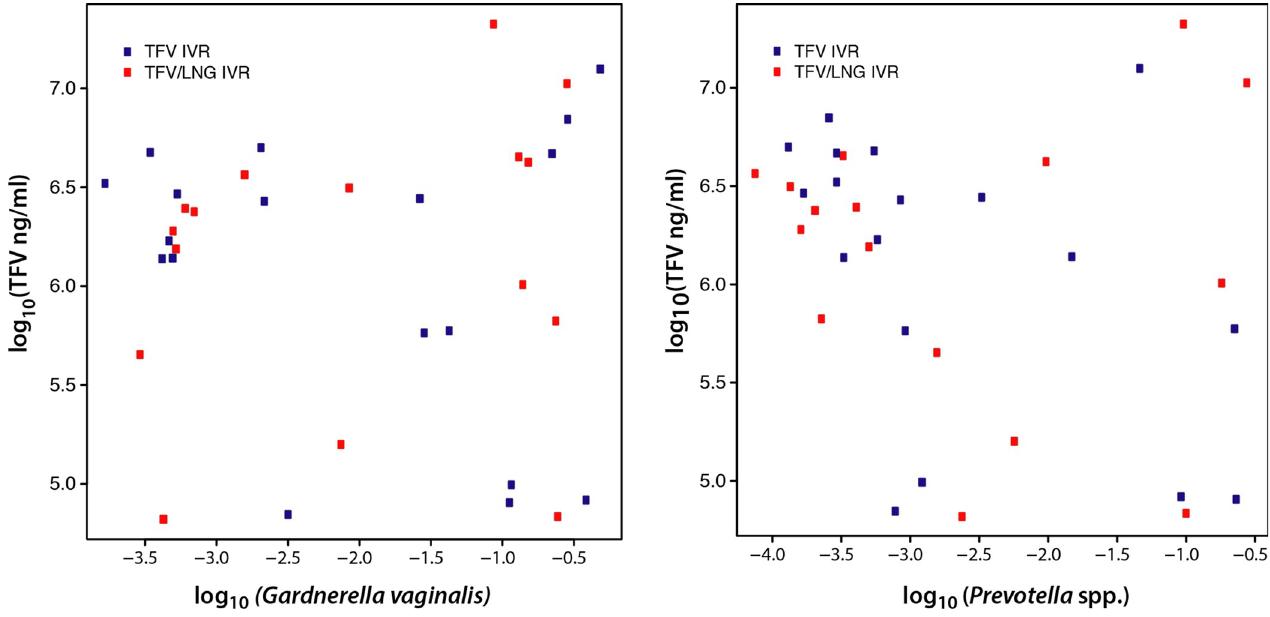
Fig 5. Plot of the log 10 relative abundances of G . vaginalis and Prevotella spp. and log 10 of TFV (ng/ml) in CV aspirates at visit